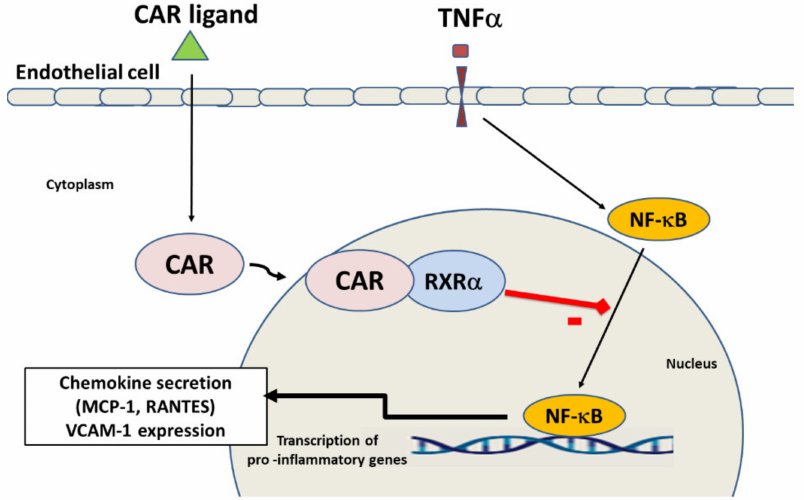
Figure 7. Graphical abstract showing the effects of CAR activation in endothelial cells. Activation of CAR by a ligand, promotes its translocation from the cytoplasm into the nucleus and heterodimeriza- tion with RXR α . This complex inhibits NF- κ B activation induced by TNF α and consequently the transcription of the proinflammatory genes MCP-1, RANTES and VCAM-1 in endothelial cells. Black lines mean activation. Red line with rectangle means